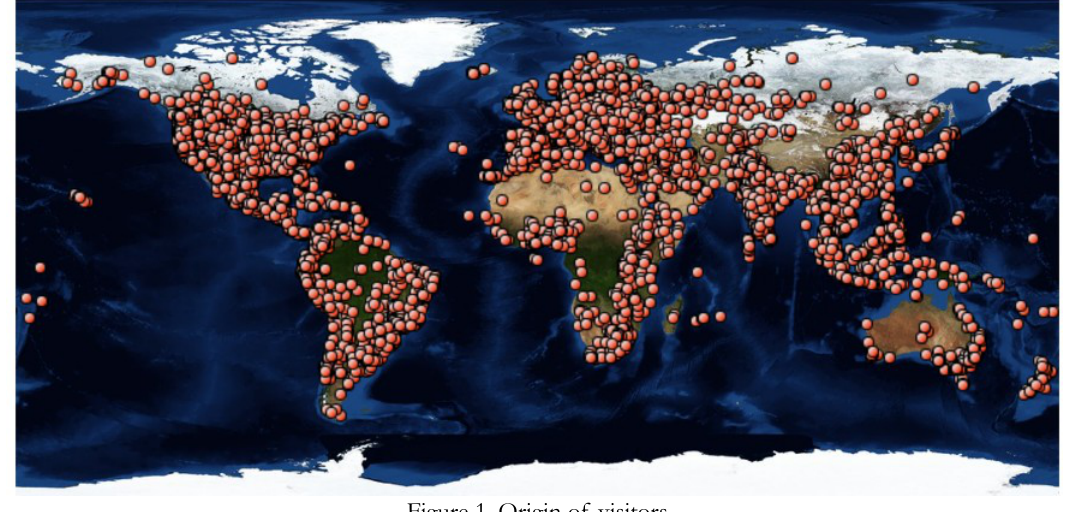
Figure 1. Origin of